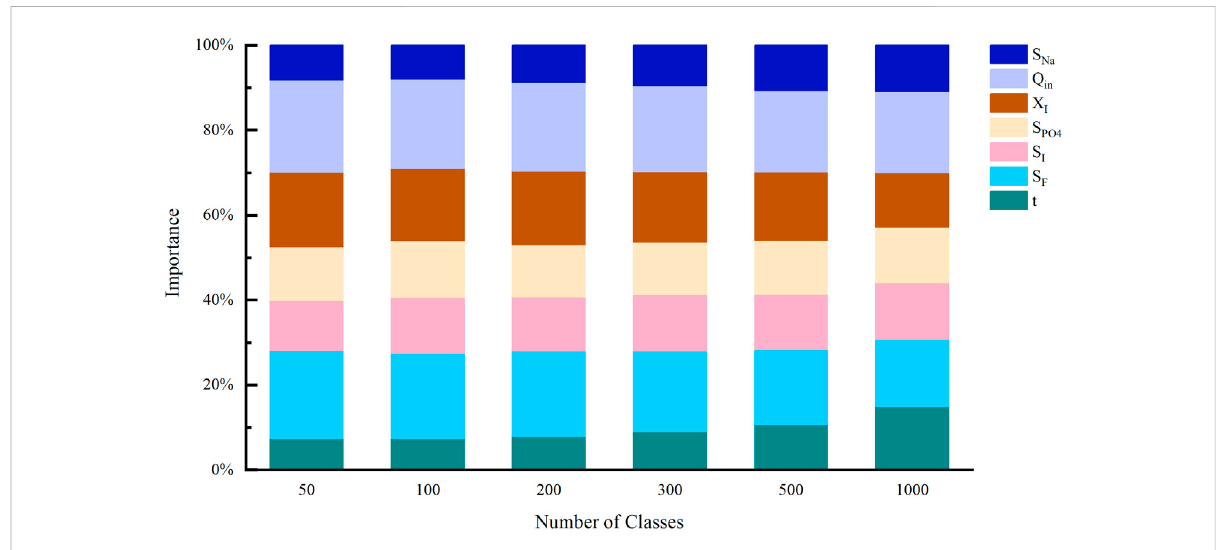
FIGURE 4 Importance of each variable to OCI with different number of